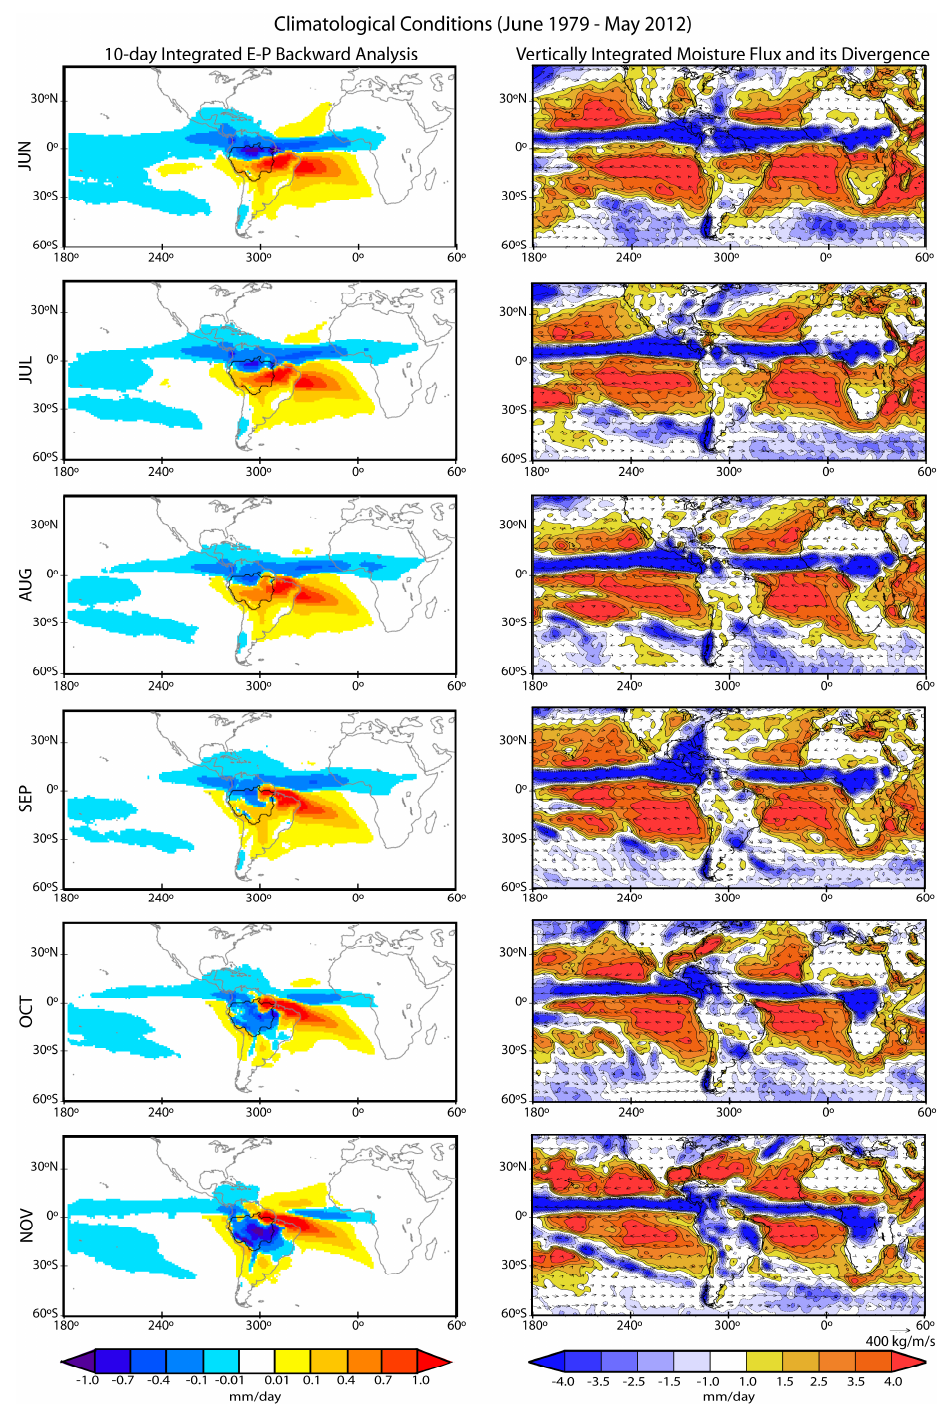
Figure 1. Left-hand column: climatological monthly 10-day integrated ( E − P ) values observed for the period June 1979–May 2012, for all the particles bound for the Amazon Basin, determined from backward tracking. Red (blue) colours represent regions acting as moisture sources (sinks) for the tracked particles. The black contour line indicates the basin area. Right-hand column: climatological monthly vertically integrated moisture flux values (vectors; measured in kgm − 1 s − 1 ) and respective divergence (shade; measured in mmday − 1 ). Data obtained from